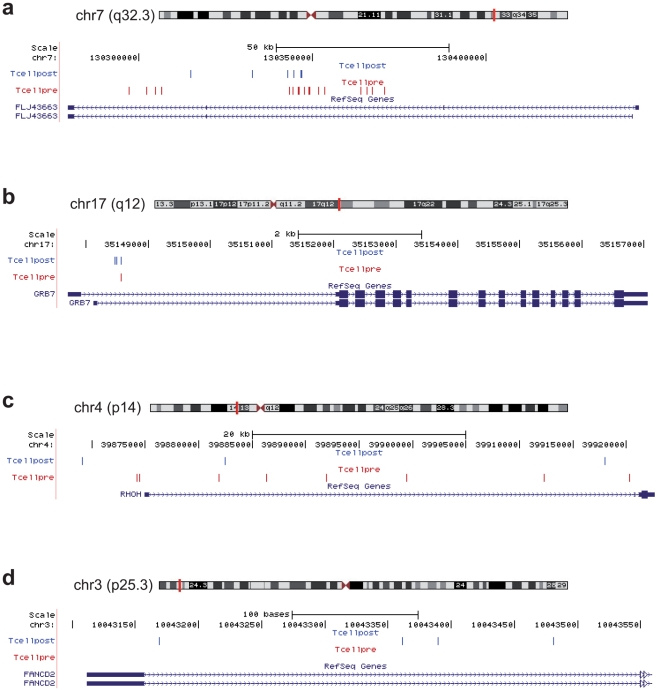
Retroviral integration clusters in pre- and post-transplantation T cells.Representation of four clusters of MLV integrations in pre-infusion (red bars) and post-infusion (blue bars) T cells, mapped by the UCSC genome browser. Location of the clusters is indicated by a vertical red bar on the corresponding chromosome (top). Zooming-in the UCSC window, the base position feature (scale bar and nucleotide number) identifies the genomic coordinates of the displayed region. The RefSeq genes track shows known human protein-coding transcripts taken from the NCBI RNA reference sequences collection. Blue boxes represent exons, arrowheads indicate the direction of transcription.